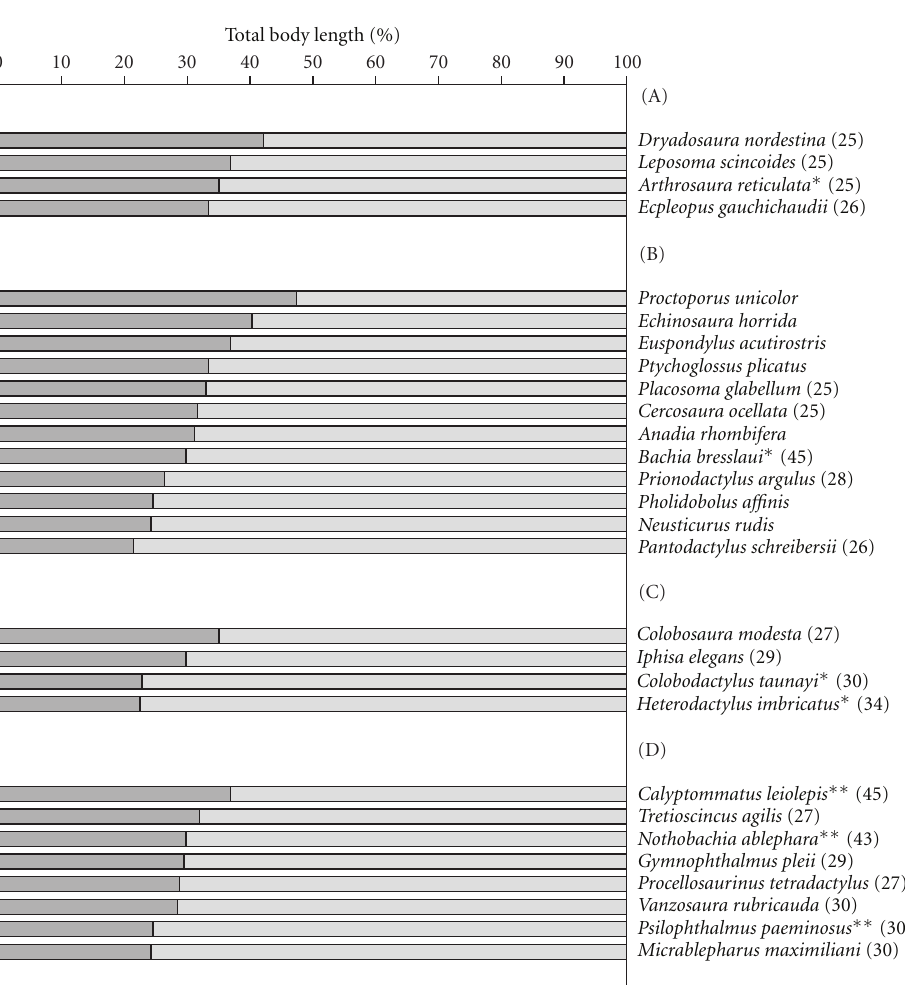
Figure 2: Body proportions of representatives from four Gymnophthalmidae tribes ( sensu Pellegrino and coauthors [11]). Snout-vent length (dark grey) and tail length (light gray) are shown as relative measures of total body length. When available, the number of presacral vertebrae is shown in parenthesis. (a) Ecpleopini; (b) Cercosaurini; (c) Heterodactylini; (d) Gymnophthalmini. ∗ Bachia -like limb reduction. ∗∗ Calyptommatus -like limb